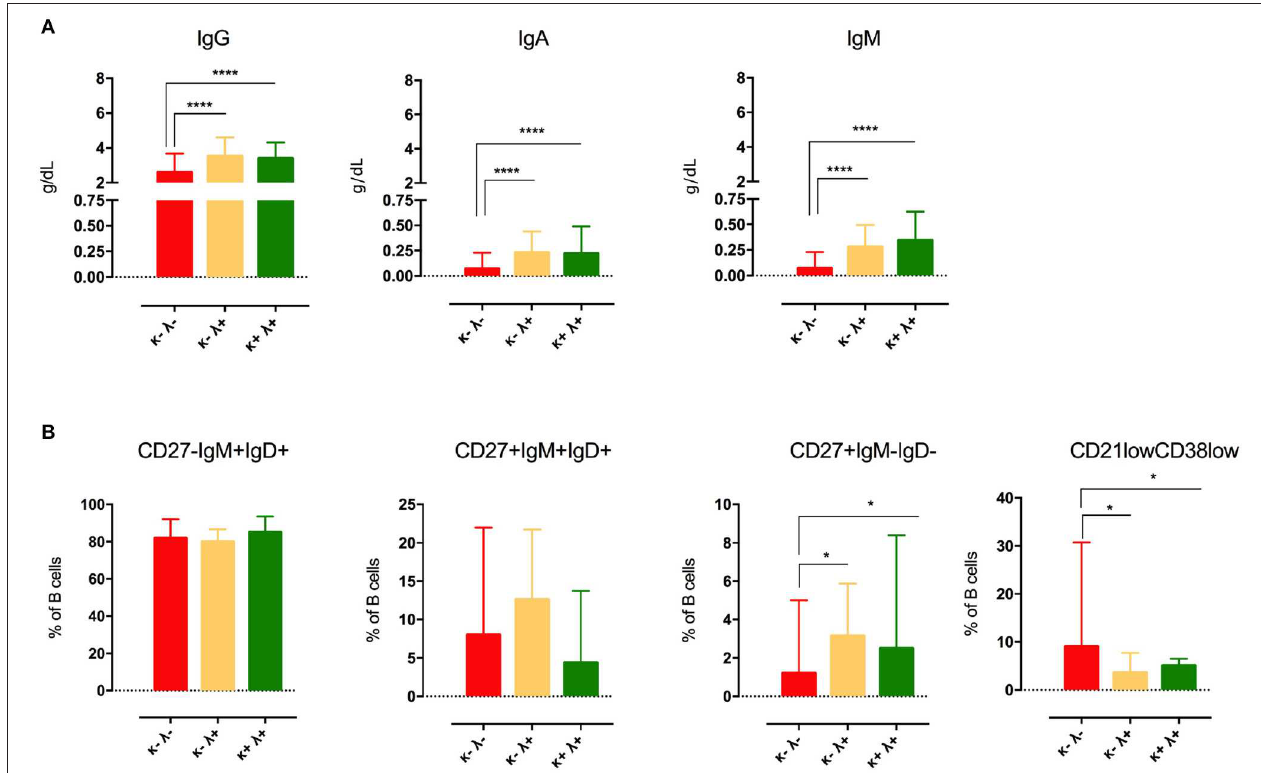
FIGURE 4 | Immunoglobulin serum levels at CVID diagnosis (A) and B-cell phenotype (B) in CVID patients grouped by sFLC levels ( κ + λ − group was censored as it was composed of only nine subjects). Median and IQR are represented. Levels of significance for comparison with CVID group by u test: * P ≤ 0.05 , **** P ≤